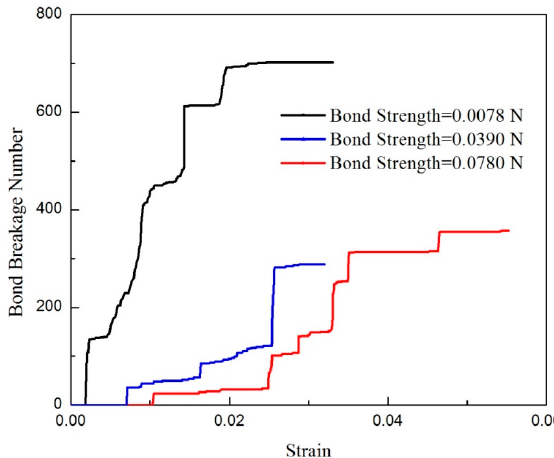
Figure 11. The number of accumulative bond breakage for three cemented samples under the pressure gradient of 2.86 Pa/m.